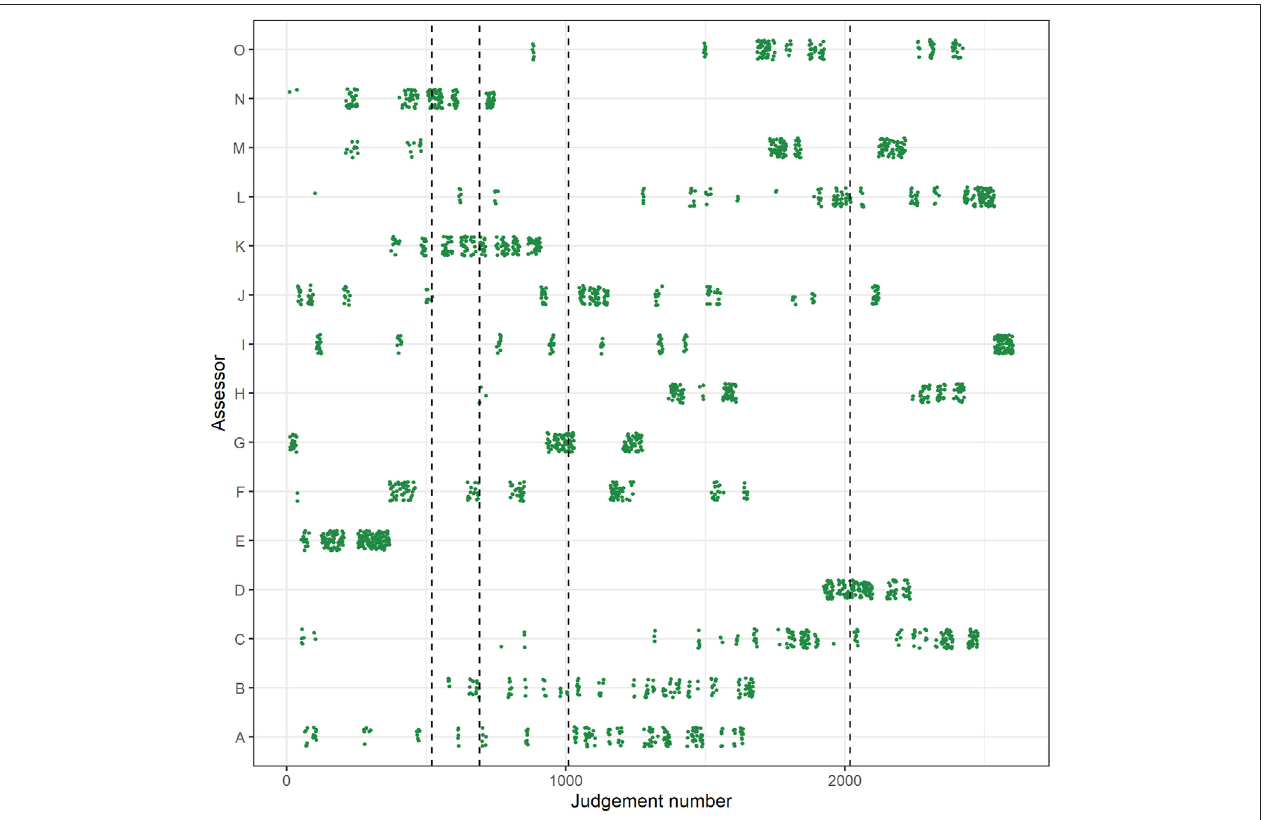
FIGURE1| Distributionofjudgmentsthroughouttheassessmentinphase1(Judgmentnumber;x-axis)byassessor(y-axis),beforereordering.Theverticaldotted linesindicate the judgmentnumber at which the estimates reached a rank-order reliability of0.50, 0.70, 0.80, and 90 (respectively from left toright). Note: jitter added to y-axis coordinates for